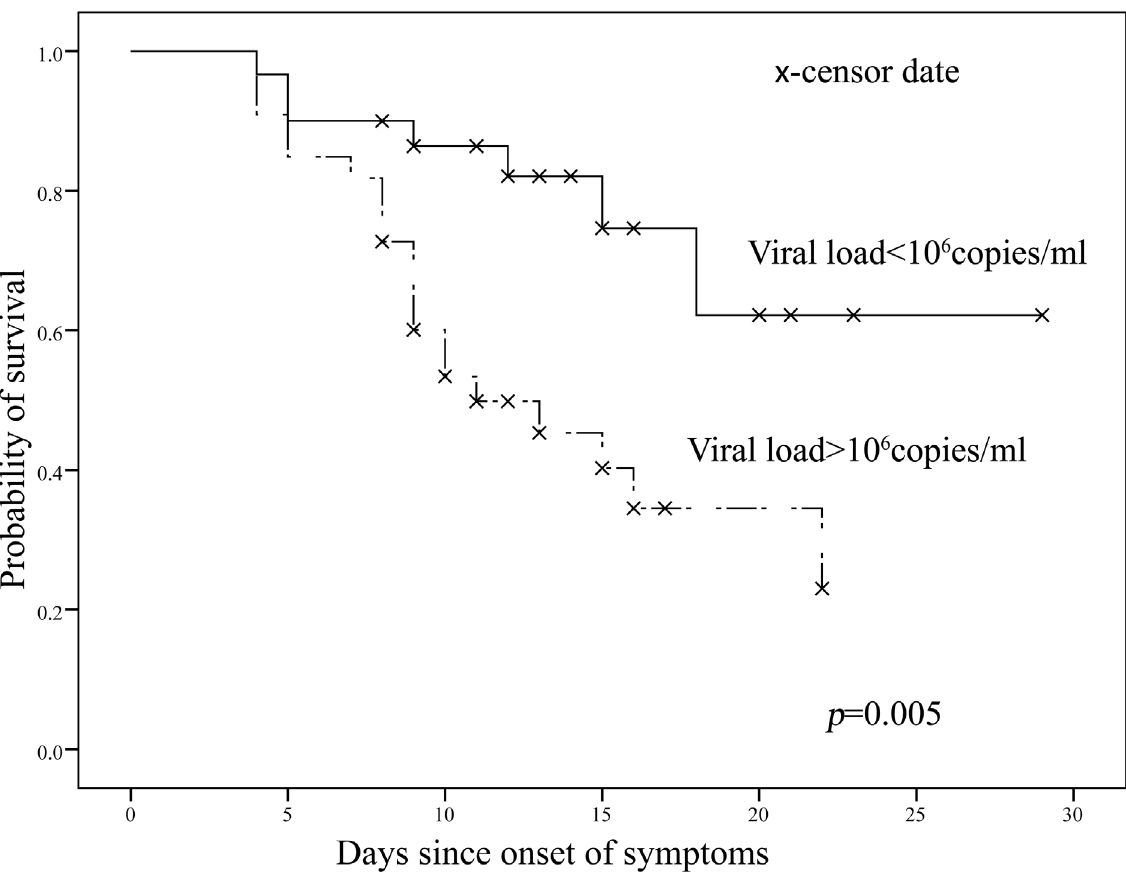
Fig 1. Kaplan-Meier survival analysis for EBV patients. Cases were divided into 2 group based on the viral load in their peripheral blood.